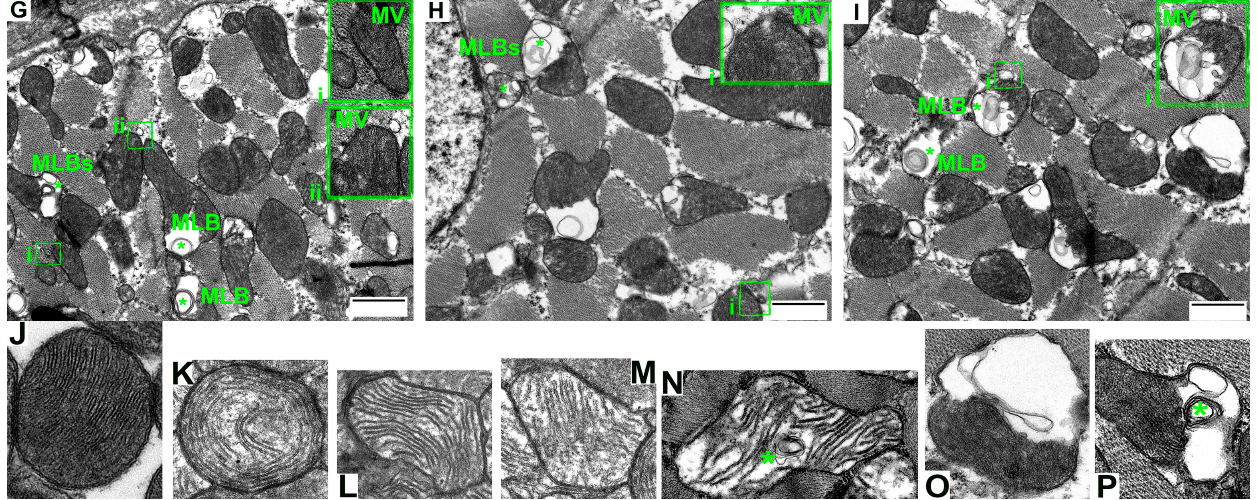
Figure 1. Representative micrographs of heart tissue in the control ( A – C ) and in experimental hyperthyroidism ( D – I ). Asterisk, multilamellar bodies (MLBs); MVs, mitochondrial vesicles; N, nucleus; L, lysosome; AL, autolysosome; LD, lipid droplet. Scale bar, 1 µ m. ( J – P ) Electron micrographs of the morphological profile of encountered mitochondria: ( J ) well-packed, intact, and organized membranes and cristae; ( K ) mitochondria with concentric “onion-shaped” cristae; ( L,M ) swollen mitochondria with a slight decrease in the electron density of the matrix and irregular cristae; ( N ) swollen mitochondria with MLBs; ( O ) damaged mitochondria, matrix vacuolization, and cristae are almost not defined; ( P ) damaged mitochondria with MLBs. The number of mitochondria analyzed in each group varied from 600 to 700 (n = 4 in each group).